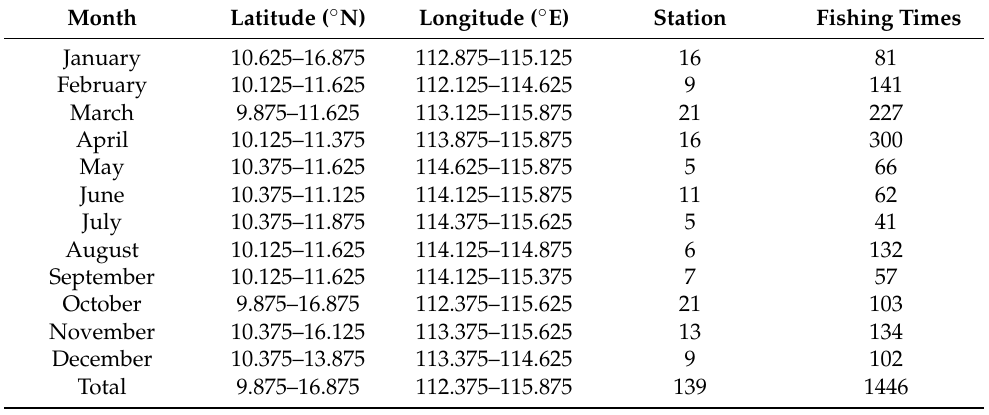
Table 1. Fishery data collected in the South China Sea in 2018.